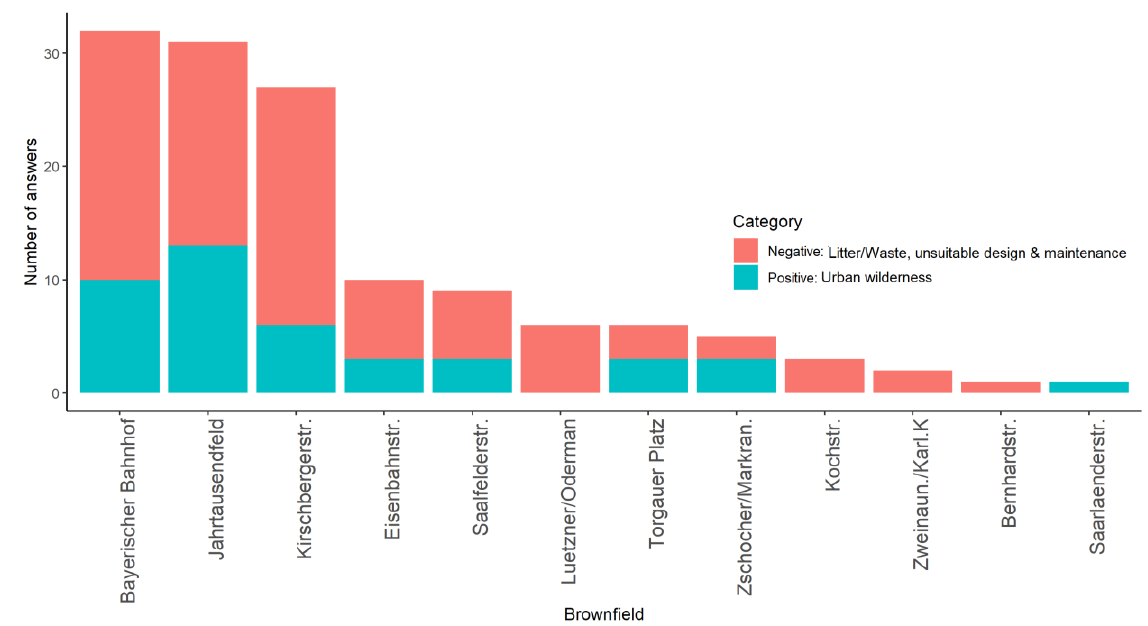
Figure A1.12: Trade-offs between urban wilderness including low maintenance as benefit (positive) and disturbances (negative) due to litter/waste and insufficient management on 12 urban brownfields, where these benefits and disturbances/disservices were specified (categorized answers from open